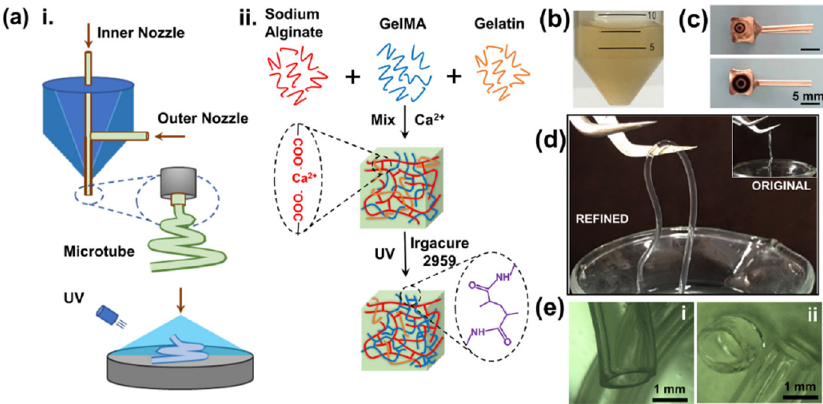
Figure 1. Preparation principle and basic properties of GelMA/gelatin/SA composite hydrogel: ( a ) The GelMA/gelatin/SA composite hydrogel is double-crosslinked using a calcium chloride solution and UV irradiation; ( b ) Preparation of the composite hydrogel precursor solution; ( c ) Different sizes of coaxial nozzles for 3D-bioprinting (two layers: inner diameter = 3.5 mm, outer diameter = 1.37 mm; three layers: inner diameter = 0.61 mm, middle layer = 1.25 mm, outer diameter = 2.27 mm); ( d ) 3D-printed artificial blood vessels optimized by parameters. The upper inset image shows the vessel before optimization and a ( e ) 3D video inspection microscope observation of artificial blood vessels.